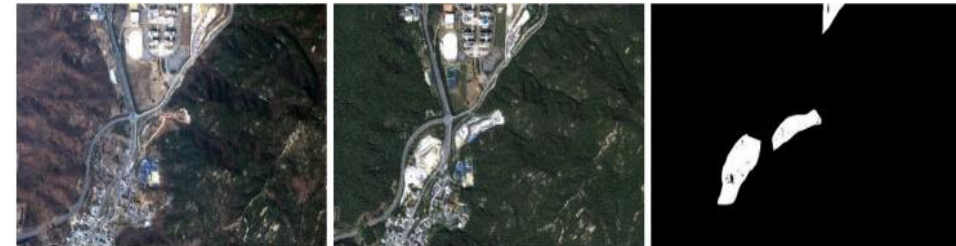
Figure 9. Test area 3 (3232 × 2206): ( left ) Image P, acquired in March 2014; ( middle ) Image C, acquired in October 2015; ( right ) Ground truth.